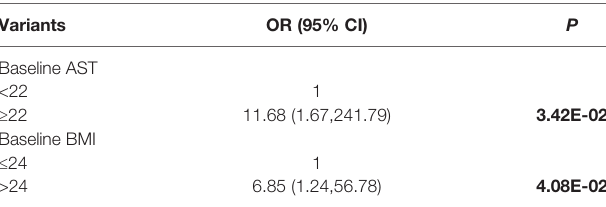
TABLE 6 | Multivariate logistic regression analysis on factors associated with disease progression after PRLT. Variants OR (95%